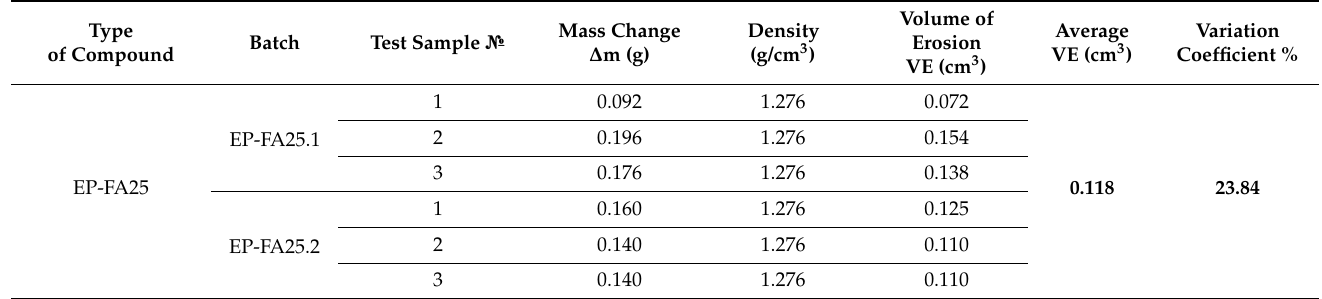
Table A9. Wear of filled epoxy binder (EP-FA25) at 100 ◦ C at an impingement angle of 90 ◦ .